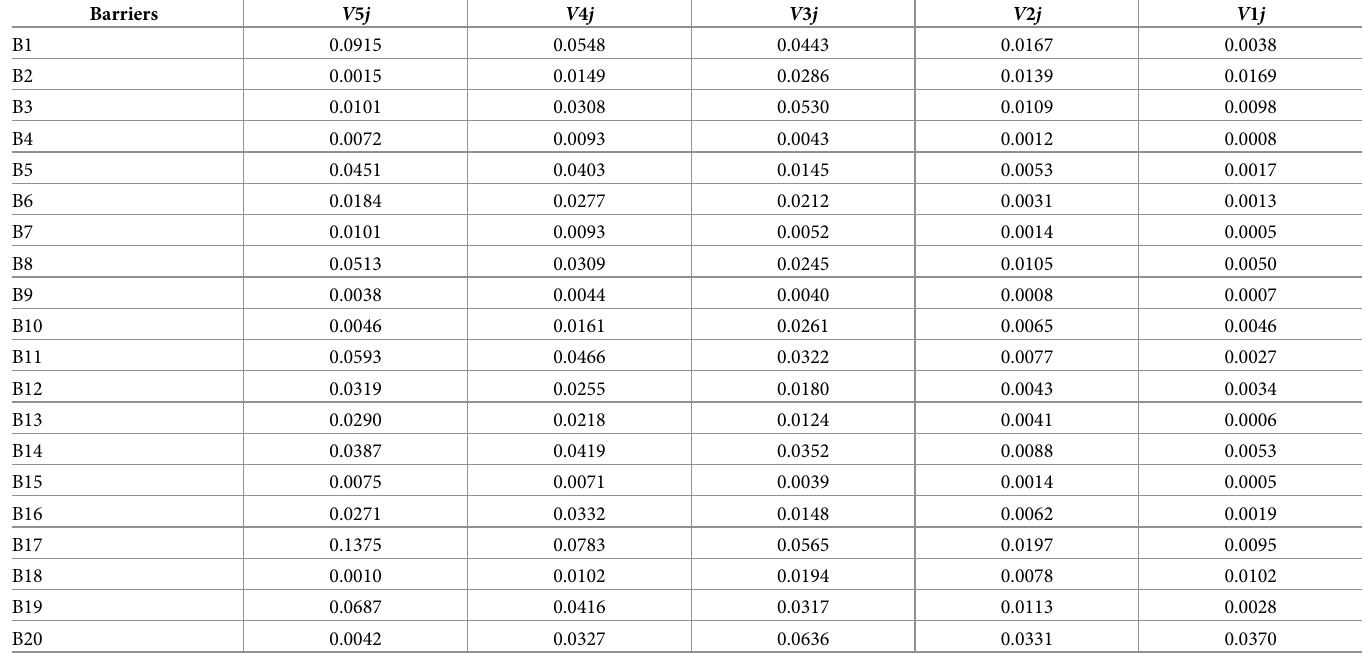
Table 3. Weighted normalized decision